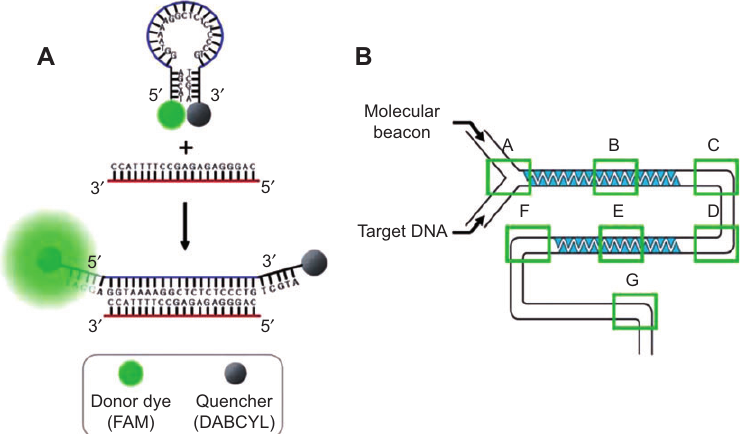
Figure 9 (A) Schematic representation of the molecular beacon and its operating principle. Target hybridization leads to the separation of the fluorophore (FAM) and quencher (DABCYL) and a consequent fluorescent signal. (B) Schematic representation of an alligator-teeth- shaped PDMS microfluidic channel. The seven boxes correspond to the fluorescence measurement areas (Kim et al. 2007